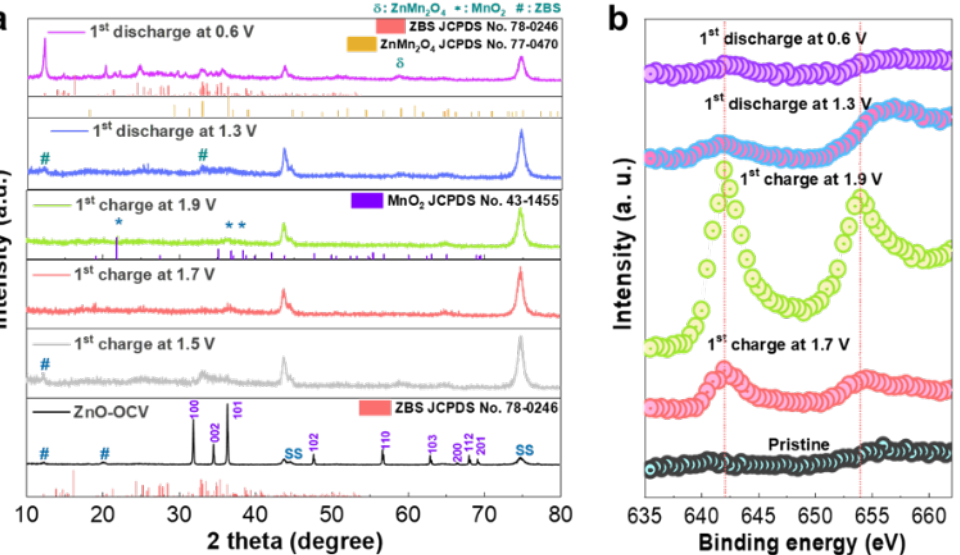
Figure 3. ( a ) Ex situ XRD analysis at different depths of charge/discharge voltages in ZMS electrolyte and ( b ) ex situ XPS profiles of Mn 2p at different depths of charge/discharge voltages in ZMS electrolyte.